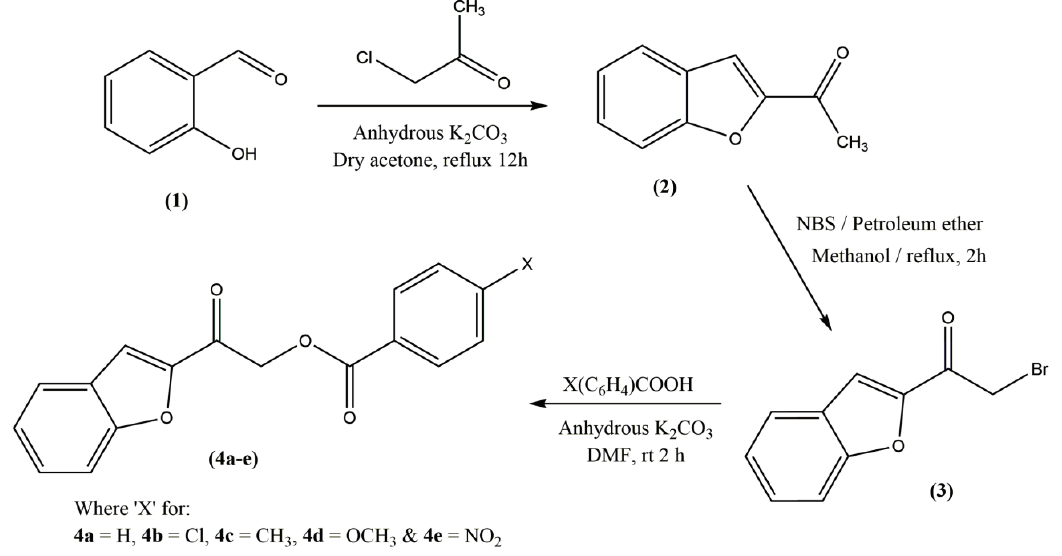
Figure 9. Reaction scheme for the synthesis of target compounds 4 ( a – e